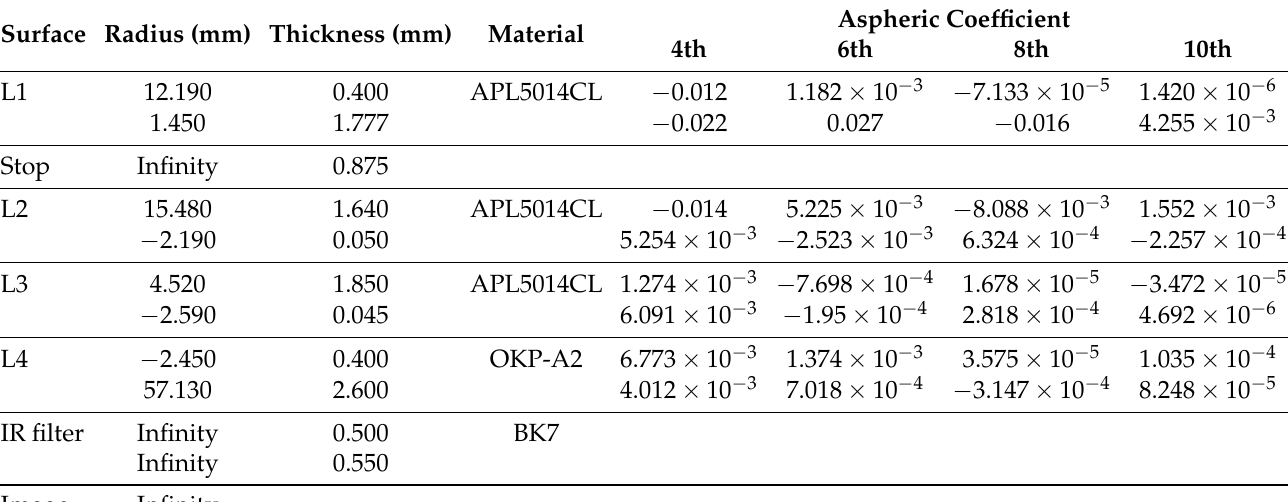
Table 2. Lens data of the optimized system.